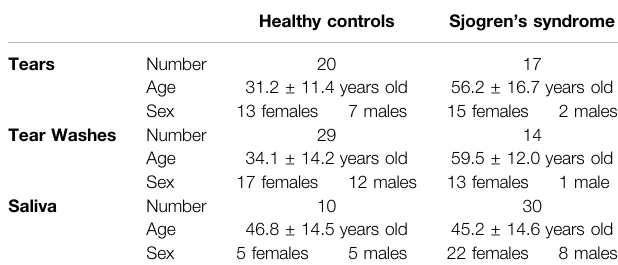
TABLE 1 | Patient ’ s information.